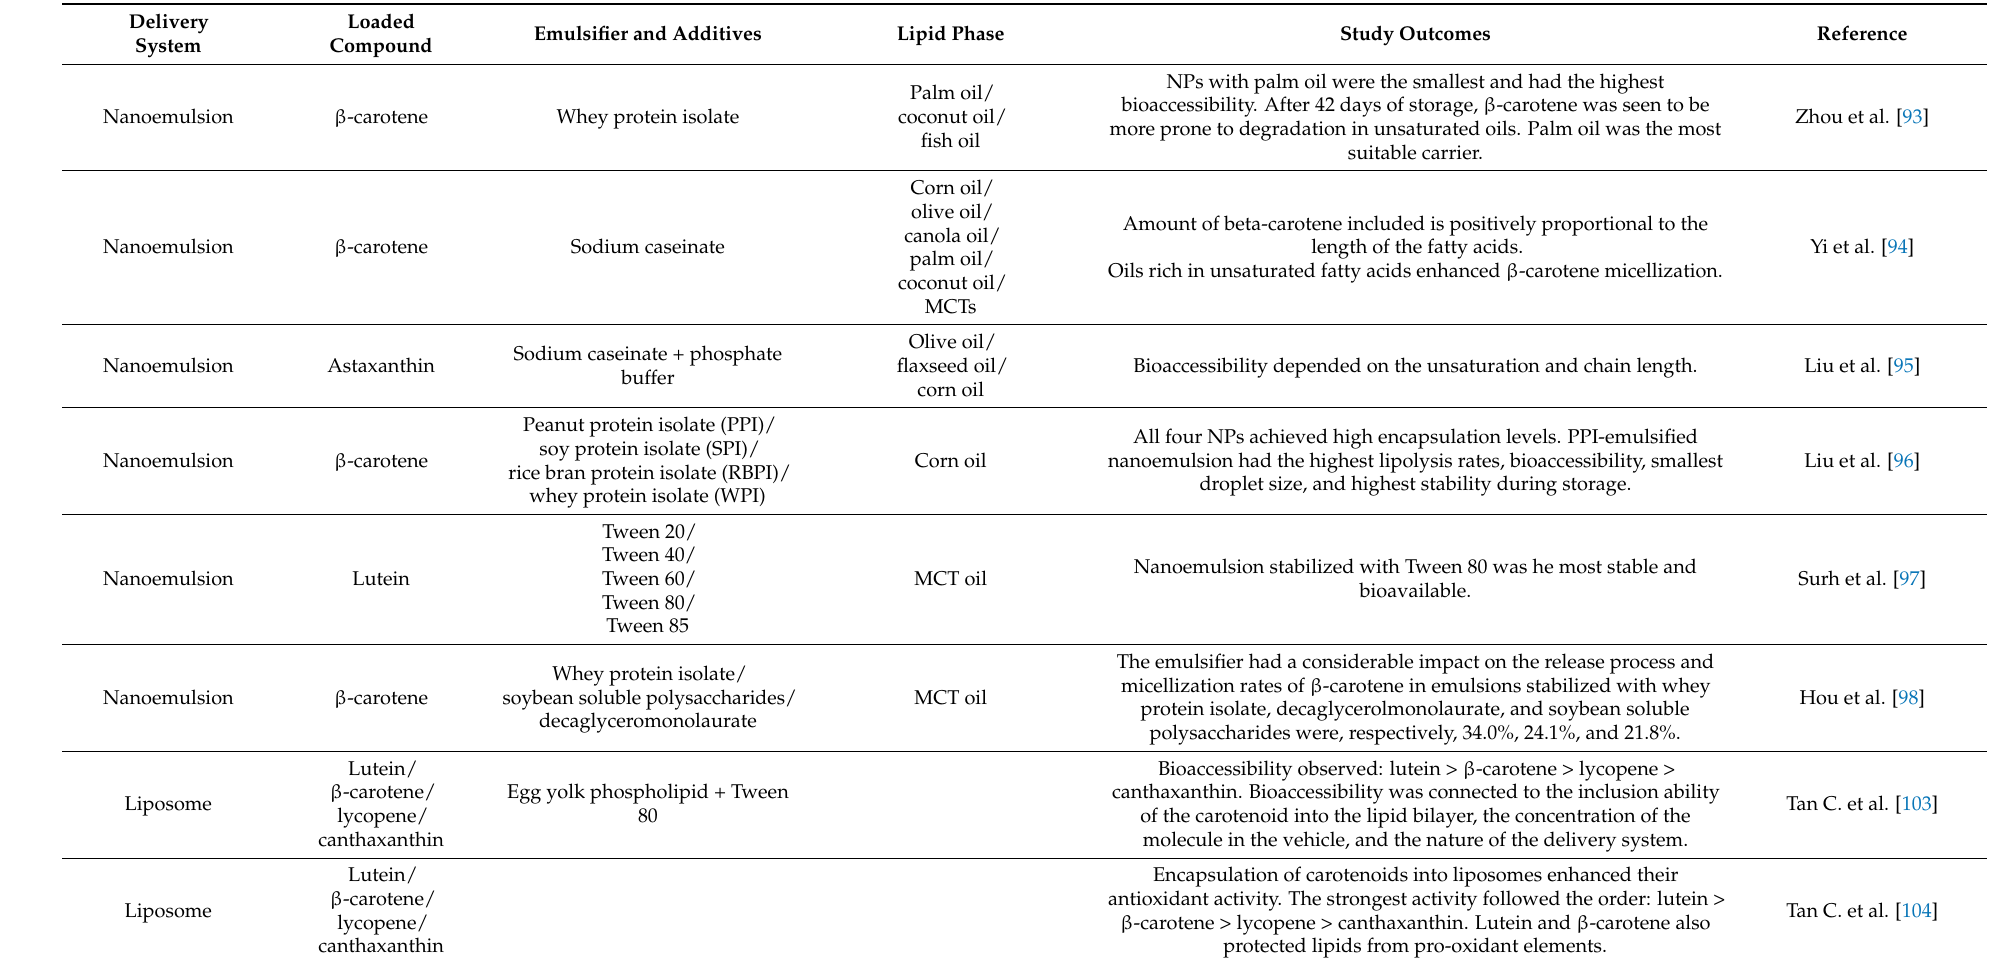
Table 1. Summary of different studies testing the encapsulation of carotenoids in lipid-based